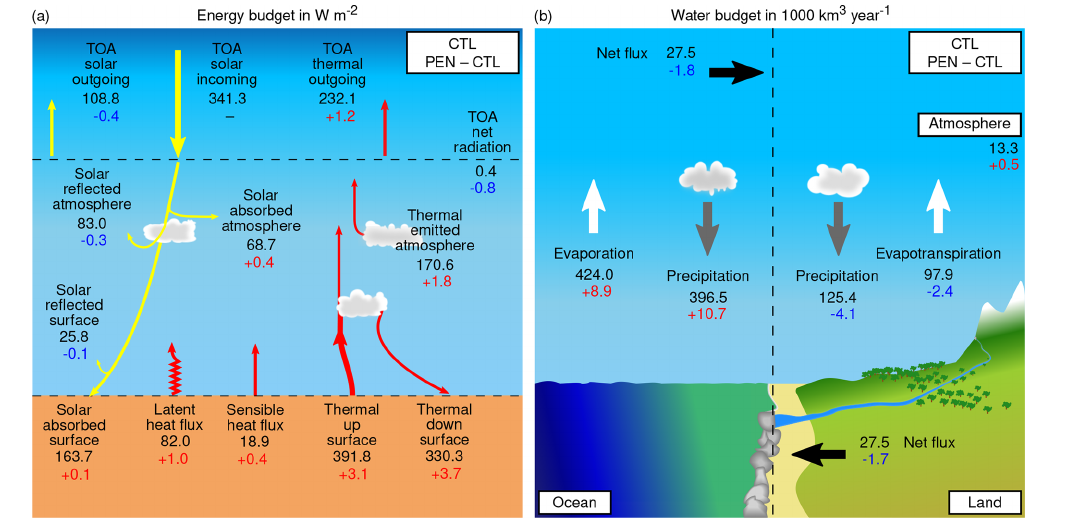
Figure 5. Global average annual mean energy (a) and water (b) budgets for the PEN simulation compared with the CTL simulation. Units are shown in the title of each panel. En dashes (–) show statistically non-significant differences ( α = 0 .